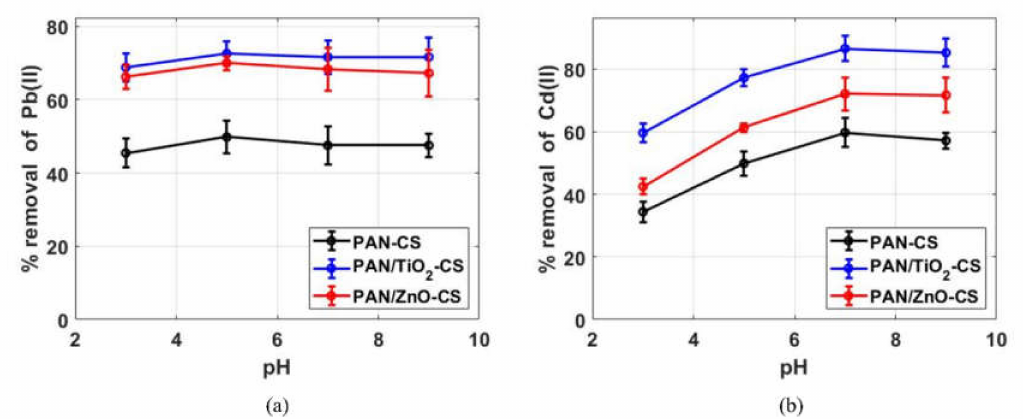
Figure 4. Removal percentage of ( a ) lead and ( b ) cadmium ions with di ff erent pH values using the bilayer nanofiber